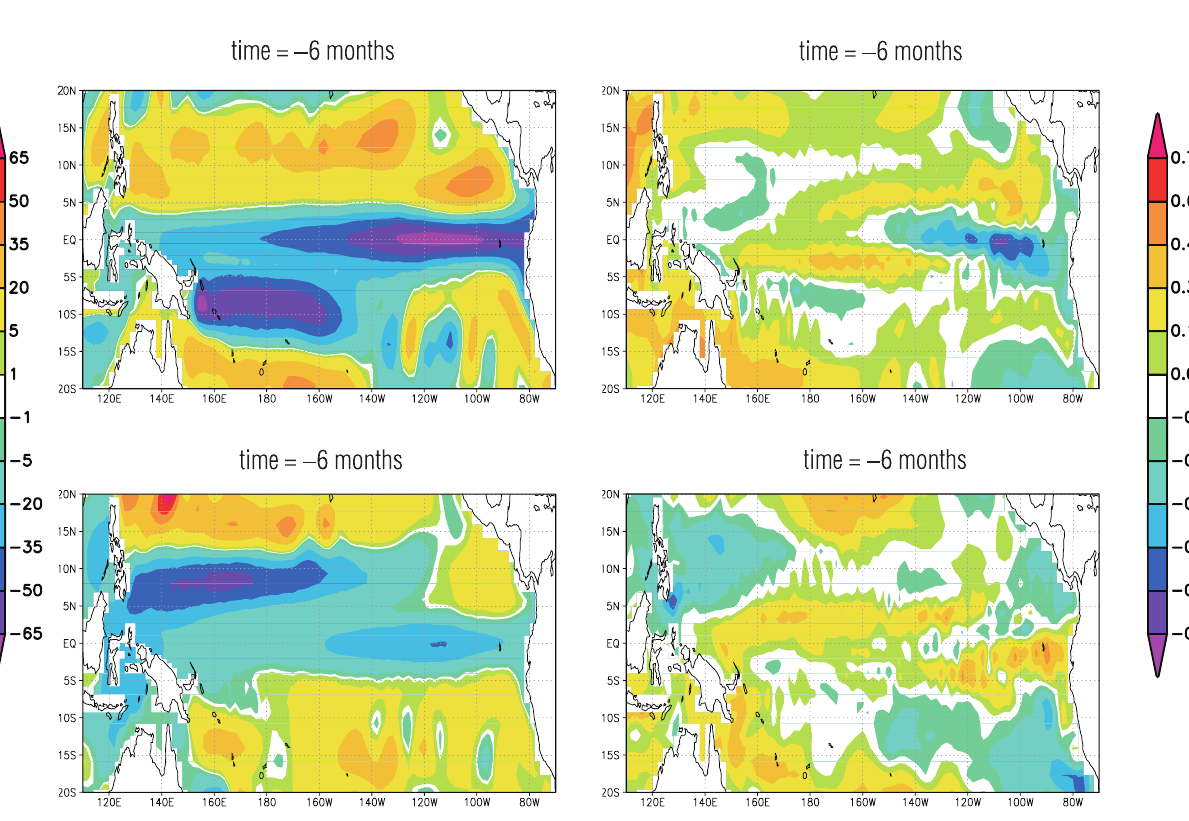
Fig. 6. Left: Heat Content (10 7 Jm − 2 ) and right : SST ( ° C) anomalies 6 months in advance of a cold SST anomaly peak for events type I ( top ) and II ( bottom